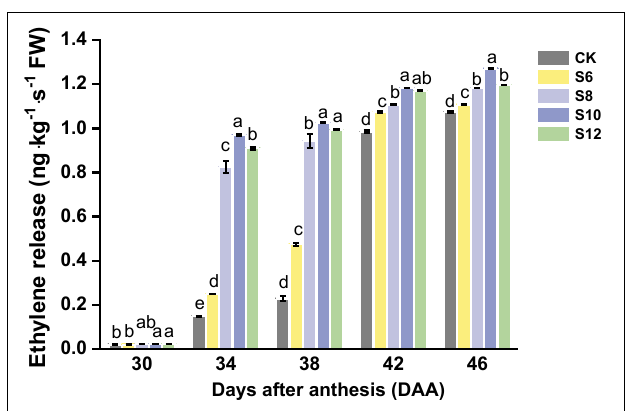
FIGURE 4 | The ethylene release during tomato fruit ripening under different supplemental blue light frequencies. Values are means ± SD ( n = 3). Different letters denote significant differences among treatments at each sampling day after anthesis separately ( p ≤